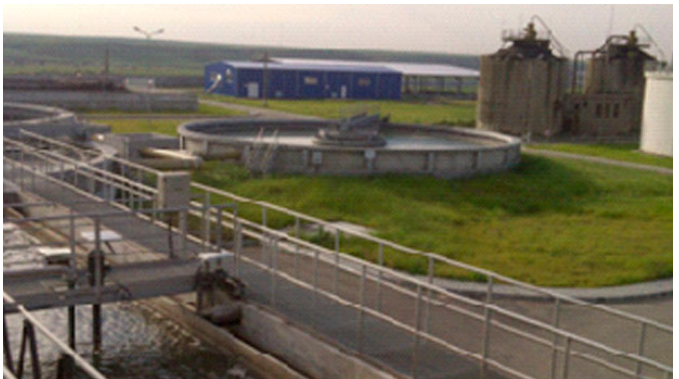
Figure 1. Alexandria wastewater treatment plant.